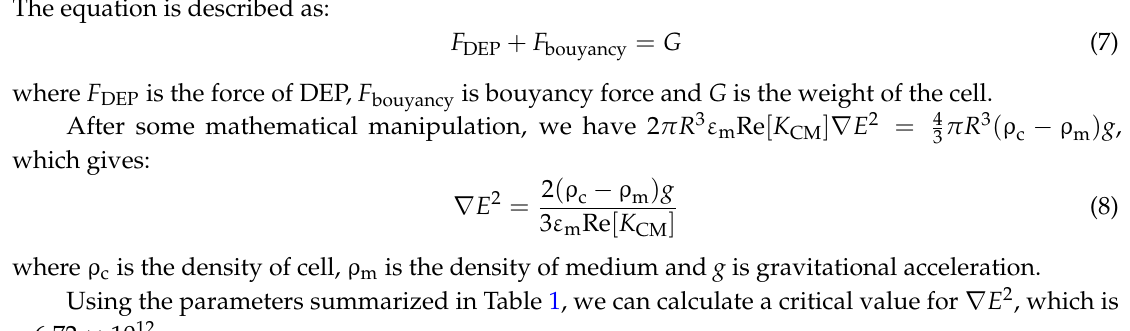
Table 1. Parameter constants of material and